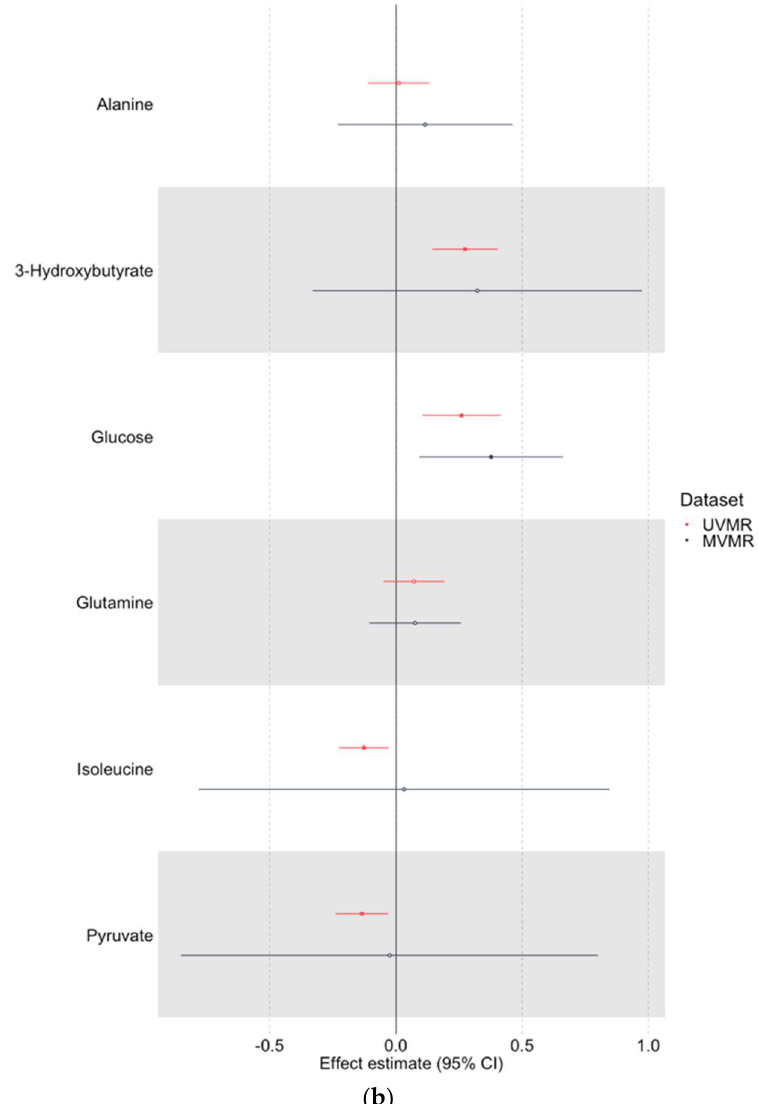
Figure 2. UVMR and MVMR effect estimates, with 95% confidence interval (CI), for six maternal metabolic traits (alanine, glucose, glutamine, isoleucine, pyruvate, and 3-hydroxybutyrate) on birth- weight in SNPs selected from UKBB ( a ) and Kettunen ( b ) GWAS. UVMR estimates were calculated using the Wald estimate (no. SNPs = 1) or IVW (no. SNPs > 1). All MVMR estimates were calculated using IVW. CI: confidence interval, GWAS: genome-wide association study, IVW: inverse variance weighting, MVMR: multivariable Mendelian randomisation, SNP: single-nucleotide polymor- phism, UKBB: UK Biobank, UVMR: univariable Mendelian randomisation.